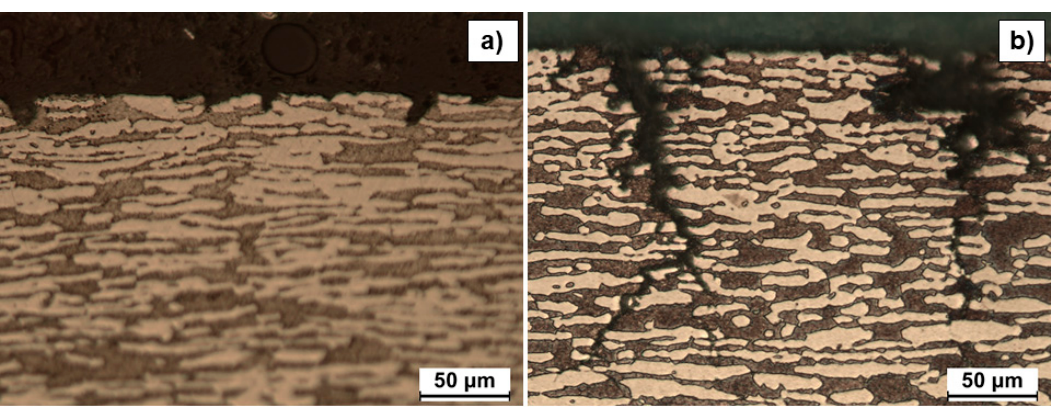
Figure 12. Micrographs of DSS 2304 aged for 5 ( a ) and 10 min ( b ) at 850 °C after SSRT in NACE solution containing 10 − 3 M S 2 O 32 − (long transverse sections, parallel to load direction).